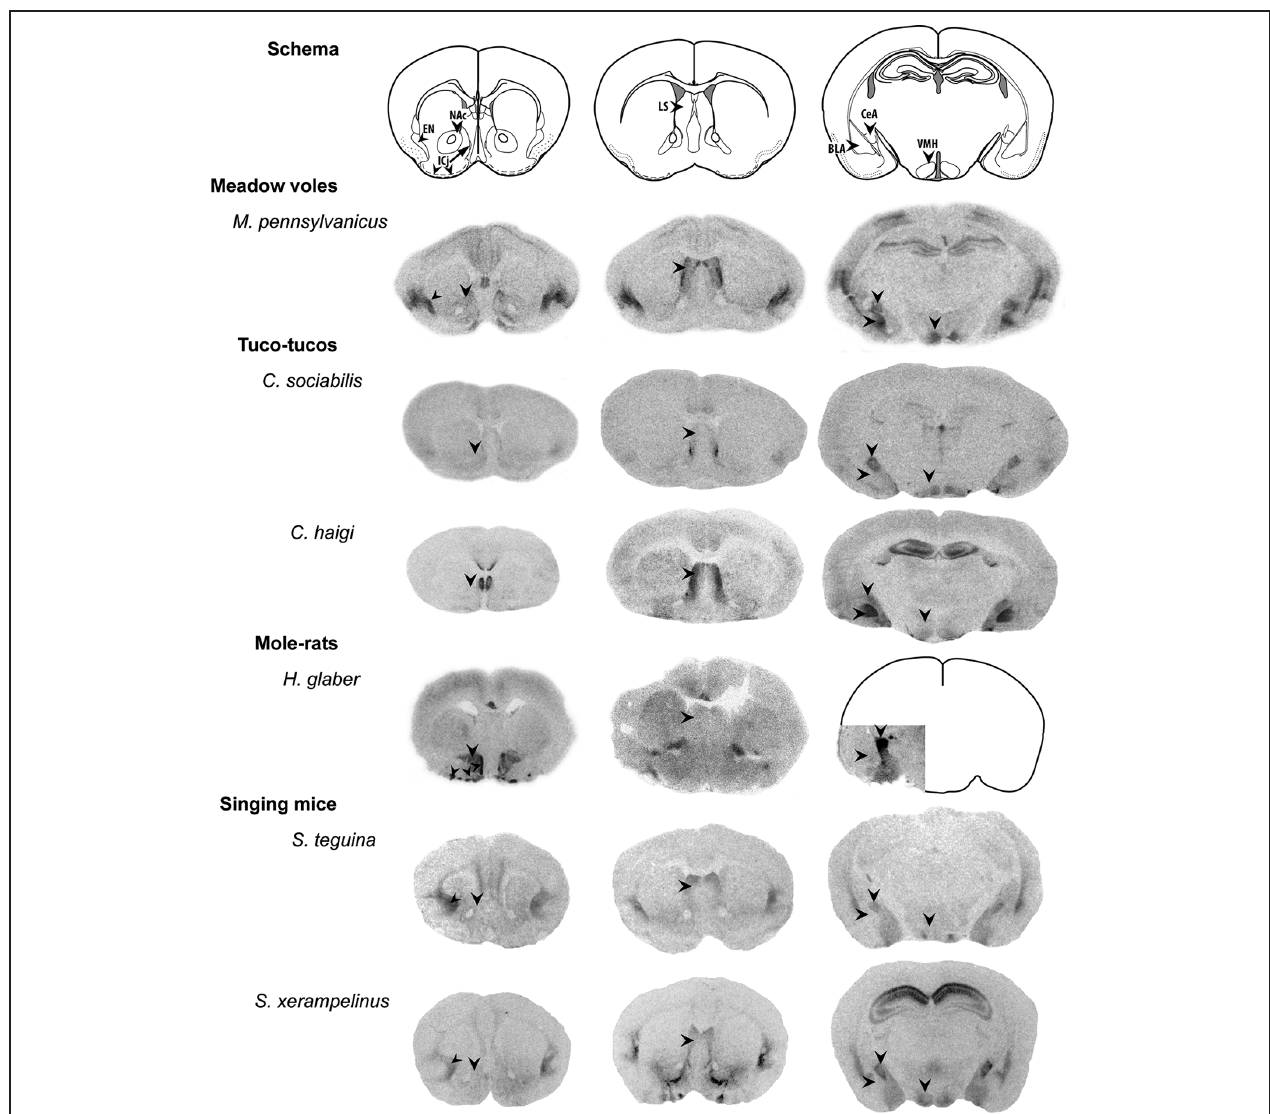
sections are adapted from figures of I 125 OVTA autoradiographic assays conducted in meadow voles (Beery and Zucker, 2010), tuco-tucos (Beery et al., 2008a), naked mole-rats (Kalamatianos et al., 2010), and singing mice (Campbell et al., 2009), used with permission of original authors and publishers. Brain sizes are not to scale and image brightness and contrast have been adjusted across species to approximately match background density; comparisons of distribution of binding may be made between species, but comparisons of density should be avoided. Arrows indicate brain regions indicated in the